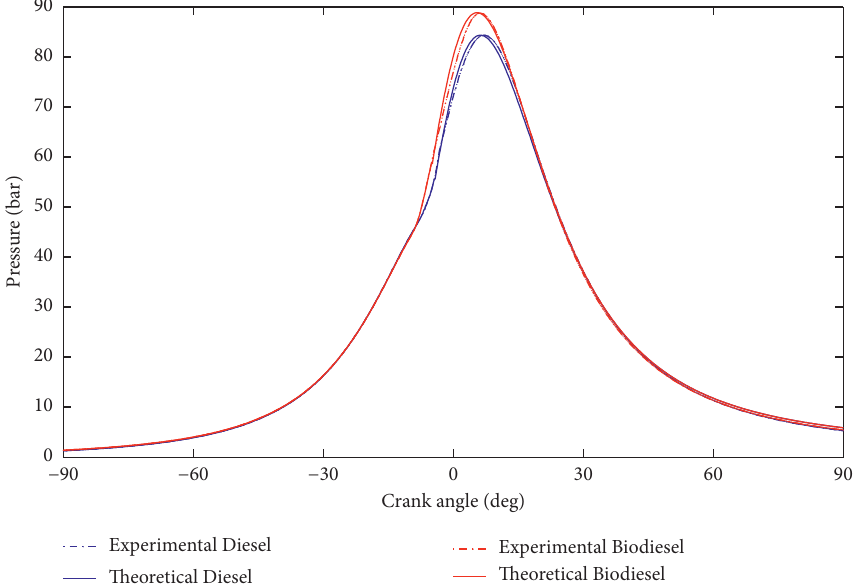
Figure 2: Comparison of experimental and theoretical pressures for biodiesel and diesel